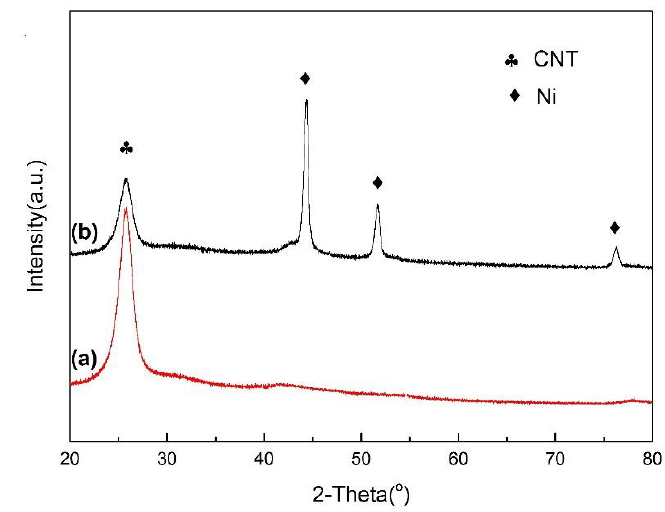
Figure 1. Characterization of the 20% Ni / CNT catalyst. (a) XRD pattern of CNT, (b) XRD pattern of 20% Ni / CNT.